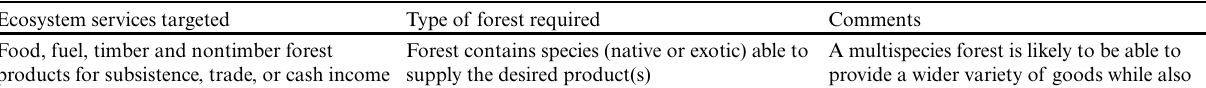
Table 1 . Examples of some ecosystem services potentially supplied by forests and the types of forest restoration required to supply these services.